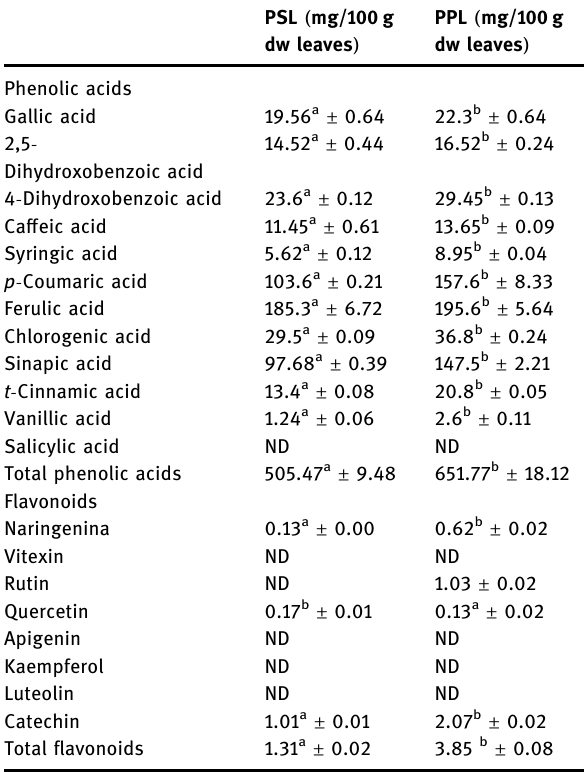
Abbreviation: as in Table 1, ND, not detected, results are mean values of three determinations ± standard deviation. Values sharing the same letter in a line are not signi fi cantly di ff erent ( P ≤ 0.05 )